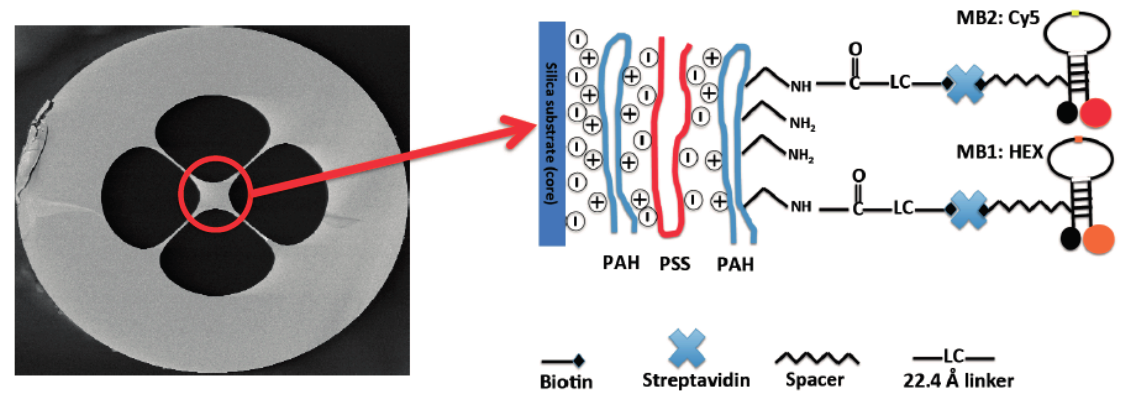
Figure 1. Schematic diagram of the final stage of the suspended core optical fiber (SCF) core functionalized with dual-type molecular beacons. Picture of the SCF cross section shown on the right side is a scanning electron microscope (SEM) image of the SCF used in this